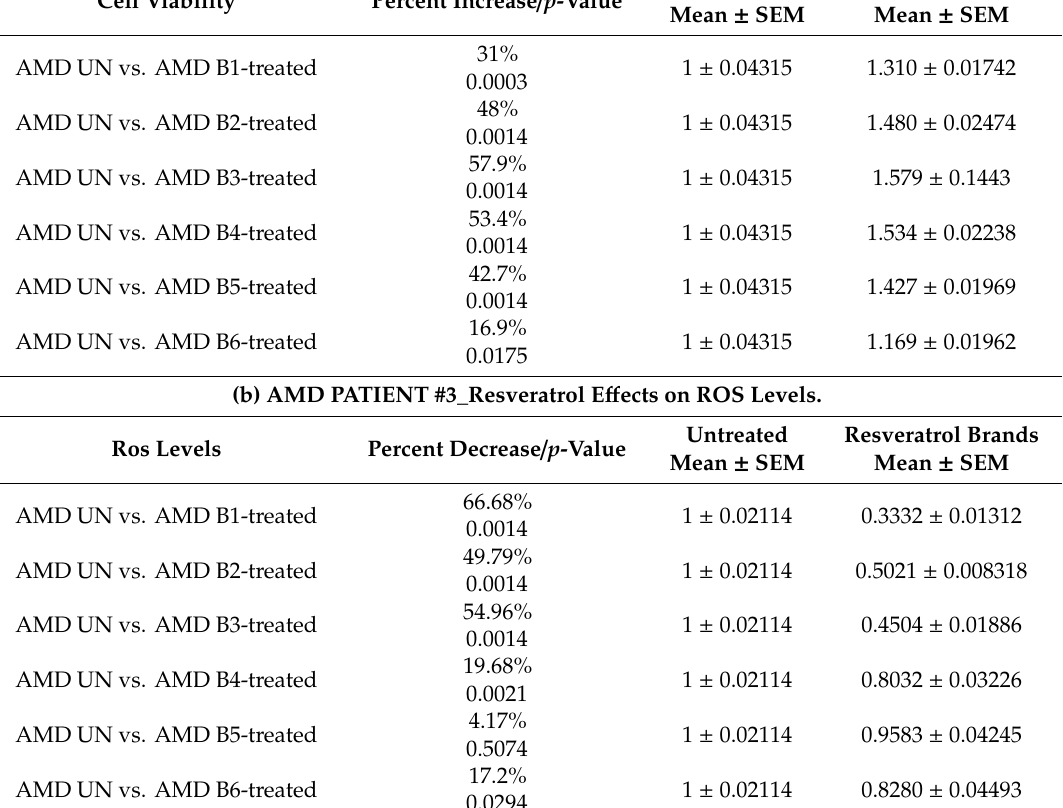
Table 5. E ff ects of resveratrol formulations on cell viability ( a ) and ROS levels ( b ) in AMD patient # 3. (a) AMD PATIENT #3_Resveratrol E ff ects on Cell